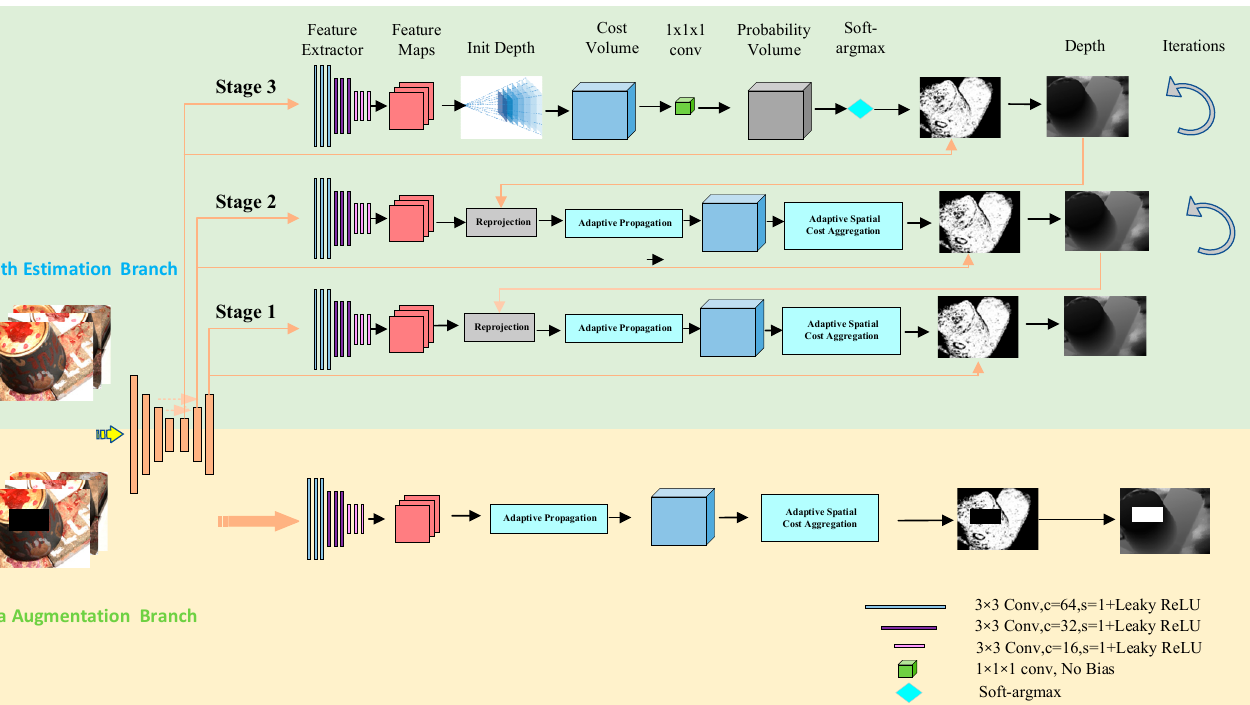
Figure 1. Network structure model. In the depth estimation branch, the depth map is initially initialized, and the depth map is obtained by calculating the cost body, 3D convolution, soft-argmax and other operations. Each stage can have multiple iterations. Upsampling the depth map can be used as the initial depth map for the next stage. The data augmentation branch and the depth estimation branch share weights in the feature extraction stage.